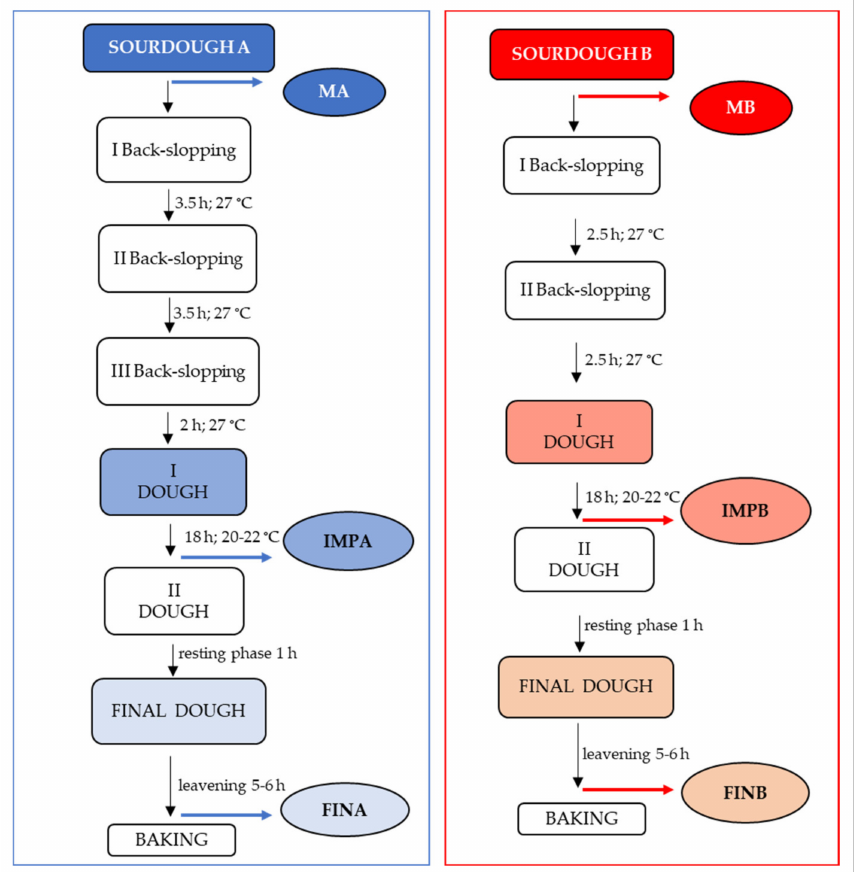
Figure 1. Artisanal Panettone production using two different sourdoughs (MA and MB). The samples highlighted were collected concurrently at the same stages for their